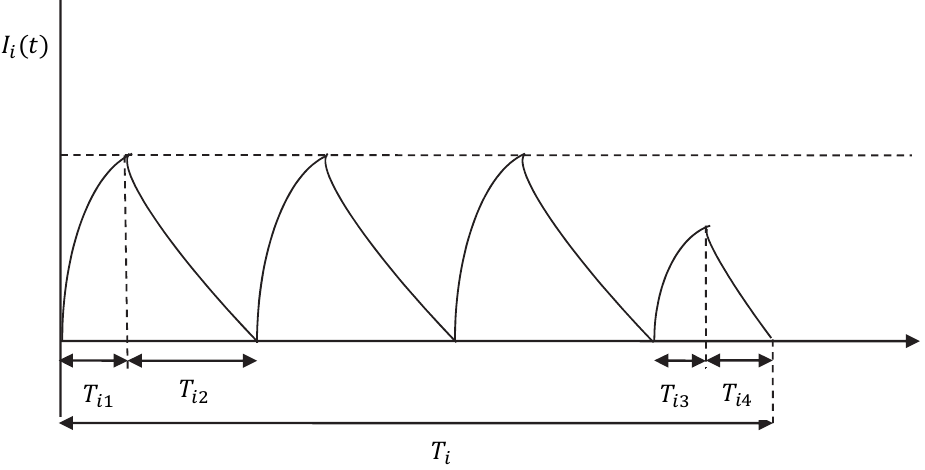
Fig. 2. Serviceable inventory level of 3 production setups and 1 rework setup